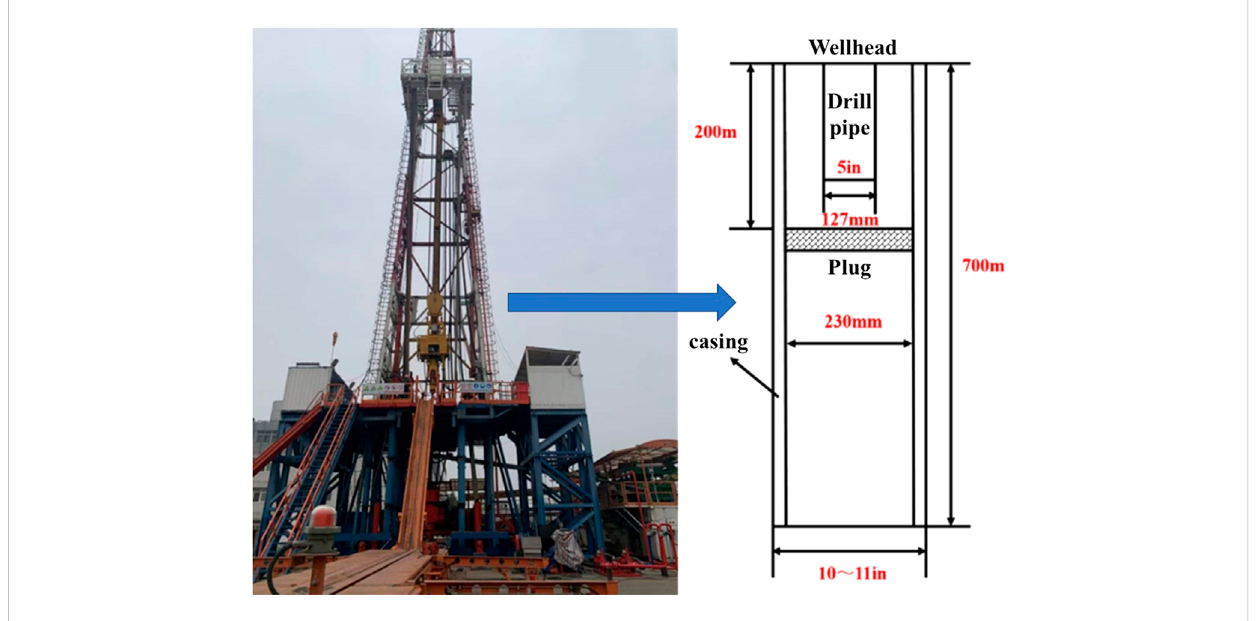
FIGURE 5 Field test drilling